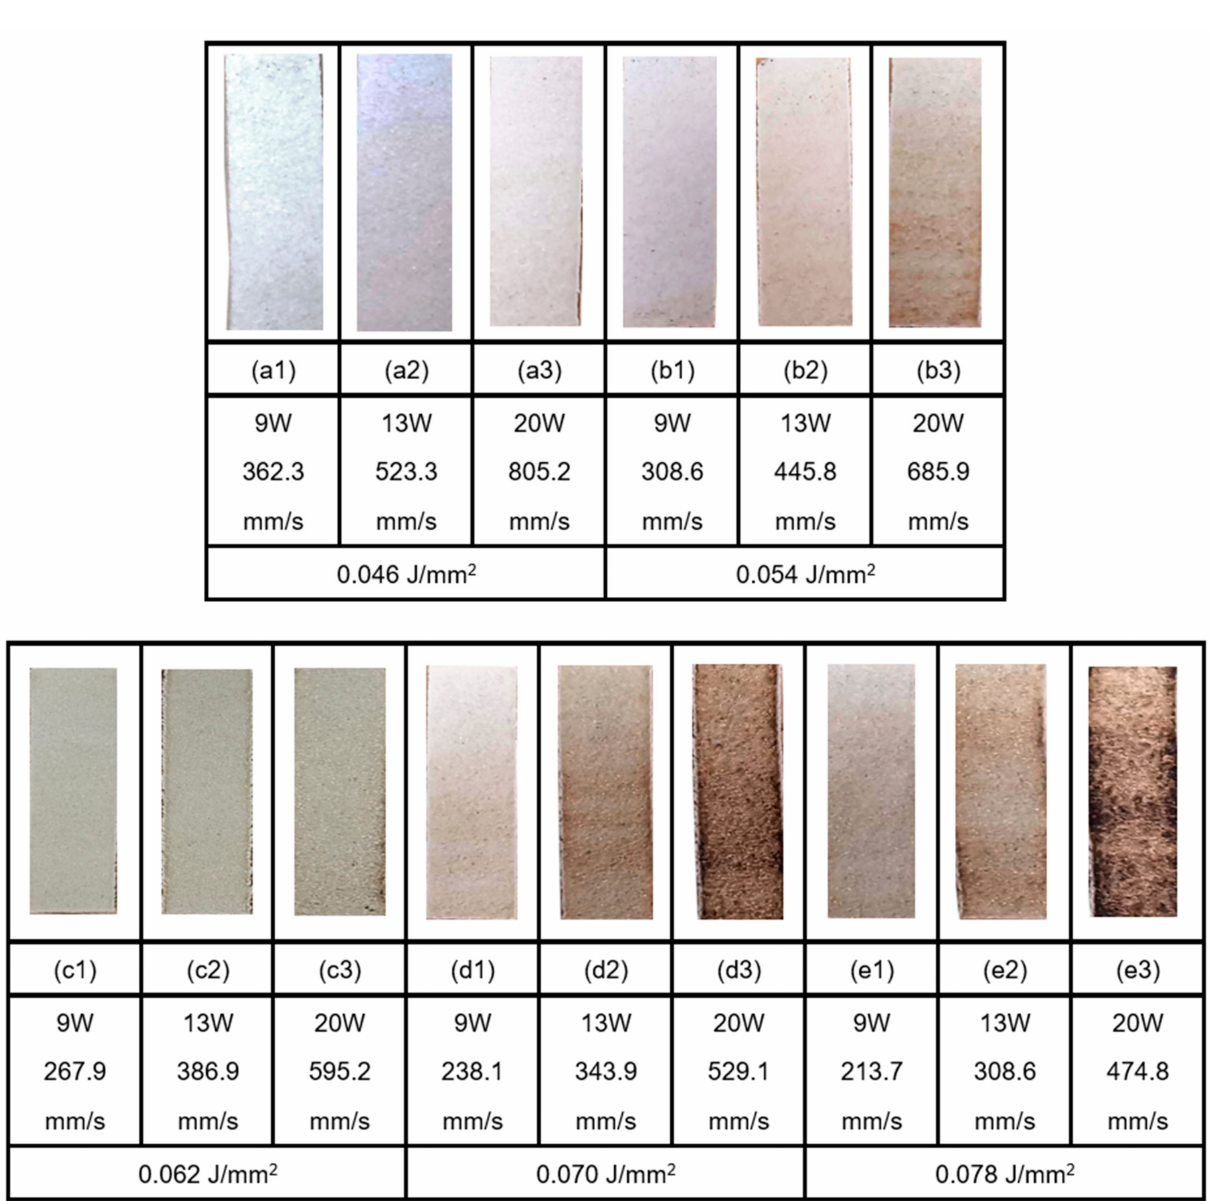
Figure 3. Single layer samples of PPSF produced by SLS; the energy density of 0.046 J/mm 2 , 0.054 J/mm 2 , 0.062 J/mm 2 , 0.070 J/mm 2 , and 0.078 J/mm 2 correspond with group ( a – e ), respectively. Laser power of 9 W, 13 W, and 20 W are used for the first, second, and third sample in the group, respectively, with varied scanning speed. All samples are of 30 × 100 mm